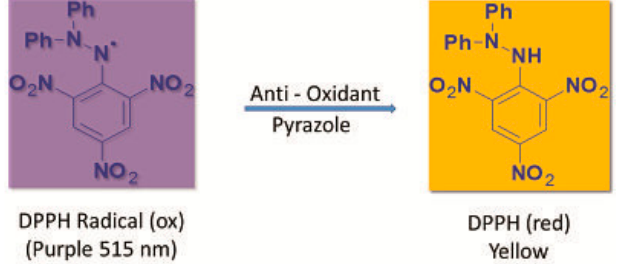
Scheme 2. Visual change in the coloration in DPPH assay.